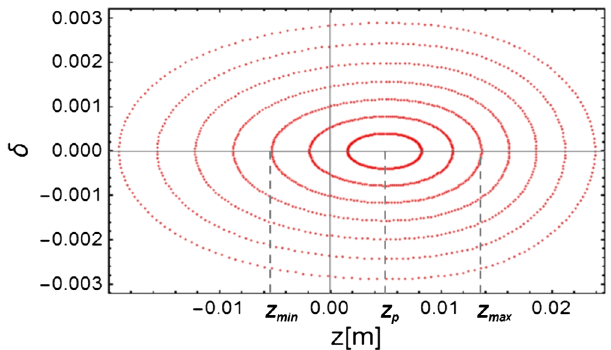
FIG. 3. Distorted particle ’ s trajectory in longitudinal phase space. Each circular set of points corresponds to a specific value of